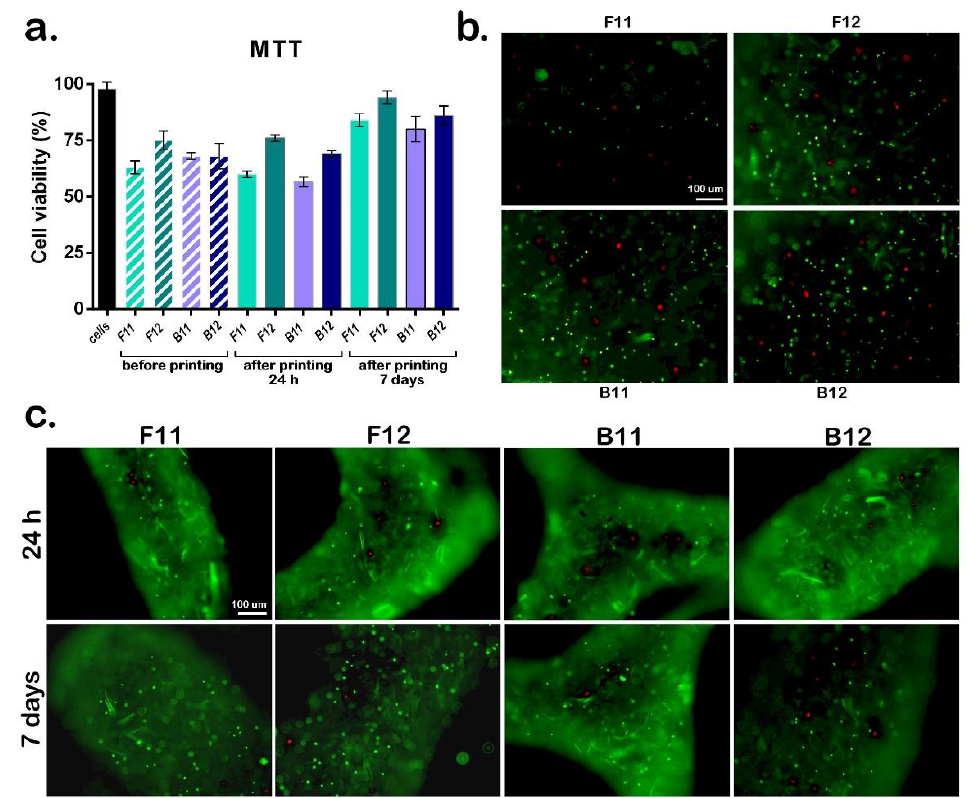
Figure 6. 3D bioprinted scaffolds biocompatibility assessment. Quantitative evaluation of cell viability by MTT ( a ) showed comparatively viability of cells in culture, cell viability in bioink and cell viability in the bioprinted scaffolds after 24 h and 7 days of culture. LiveDead staining and confocal microscopy highlighted the ratio between live (green) and dead (red) cells before printing ( b ) and after printing ( c ) in 3D cultures exposed to standard conditions for 24 h and 7 days. Scale bar 100 μm.